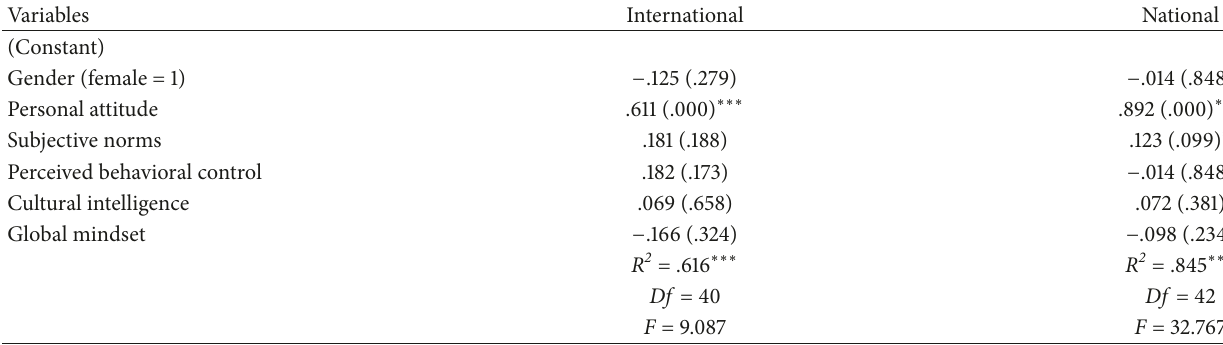
Table 5: Direct effects on (international) entrepreneurial intention.